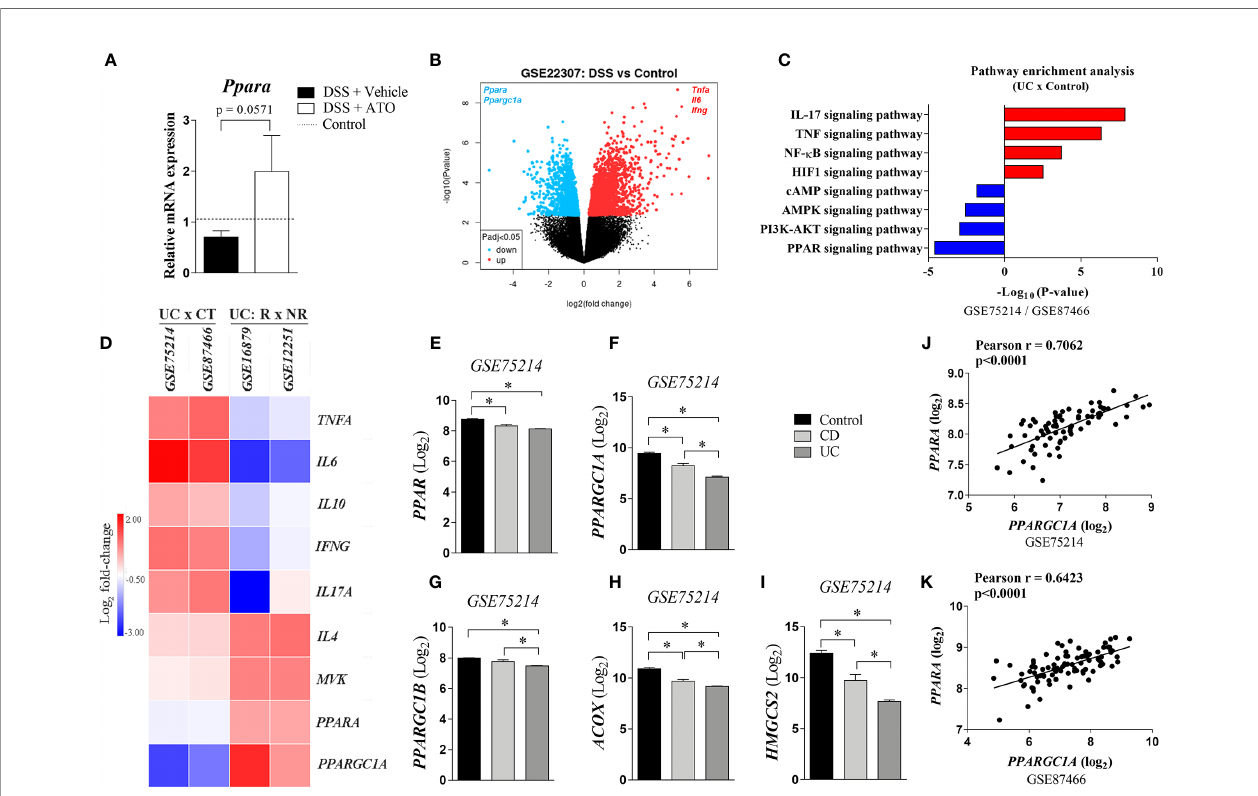
FIGURE 5 | PPAR- a expression is decreased in the in fl amed intestine and restored by ATO treatment. (A) C57BL/6 WT mice were exposed to 3% (w/v) DSS in drinking water for 6 days. Mice received oral treatment once daily for three days (days 3-5) with saline (vehicle) or 10 mg/Kg/day ATO. Middle colon fragments were used for qRT-PCR analysis and the differential expression of mRNA was de fi ned by the formula 2 - DD Ct . The dashed line indicates the values from healthy control mice without colitis induction. These results are representative of 2 independent experiments with 3-4 mice per group, in each experiment. (B) Data were obtained from available dataset under GEO accession GSE22307. Volcano plot shows upregulated (red) and downregulated genes (blue) signi fi cantly and differentially expressed at an adjusted p-value cutoff of 0.05. (C) . Differentially expressed genes were obtained from GSE75214 and GSE87466 datasets. They were fi ltered by either logFC<-1 (downregulated genes) or logFC>1 (upregulated genes) and by adjusted p value<0.05. Then, KEGG Pathway enrichment analysis was performed on the up and downregulated genes using the Metascape software. (D) Heatmap showing the relative colonic PPARA expression between healthy individuals and UC patients (GEO accession GSE75214 and GSE87466), and between responder or non-responder UC patients to in fl iximab therapy (GEO accession GSE16879 and GSE12251). The expression of in fl ammatory genes as well as enzymes related to both PPAR signaling and mevalonate pathways in the colon are also depicted. Expression data were preprocessed using a log2 transformation and normalization approach. (E – I) . PPAR a -related gene expression from colon of healthy, CD and UC patients (GEO accession GSE75214). Expression data were preprocessed using a log2 transformation and normalization approach. (J, K) . Correlation analyzes between PPARA and PPARGC1A genes using data from GSE75214 and GSE87466 datasets. Based on Kolmogorov-Smirnov normality test, we selected either Pearson or Spearman analysis for the correlation analyzes. *p<0.05. Unpaired t tests or Mann-Whitney non-parametric t test were used for 2 groups, while ANOVA test was used for 3 or more groups followed by Tukey comparison or Kruskal – Wallis (Dunns) test to determine if differences attained signi fi cant response. ACOX , Acyl-CoA oxidase 1; CT, control; DSS, Dextran sodium sulfate; HMGCS2 , 3-Hydroxy-3-Methylglutaryl-CoA Synthase 2; MVK, Mevalonate kinase; NR, Non- responder to In fl iximab therapy; PPAR- a / Ppara / PPAR , Peroxisome proliferator-activated receptor alpha; Ppargc1a/PPARGC1A , Peroxisome proliferator-activated receptor gamma coactivator 1-alpha; PPARGC1B , Peroxisome proliferator-activated receptor gamma coactivator 1-beta; R, Responder to in fl iximab therapy; UC, Ulcerative